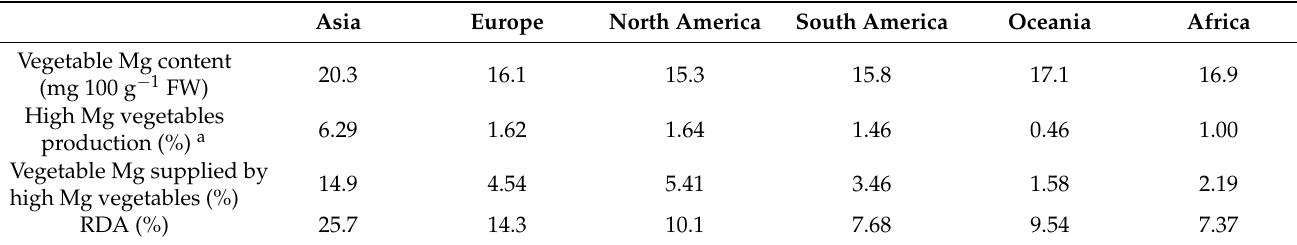
Table 1. Weighted average vegetable Mg content, high Mg vegetable production and percentage of recommended daily allowance of Mg supplied by vegetables in 6 continents. Table 2. Health and economic burden of Mg malnutrition, a case study in China.